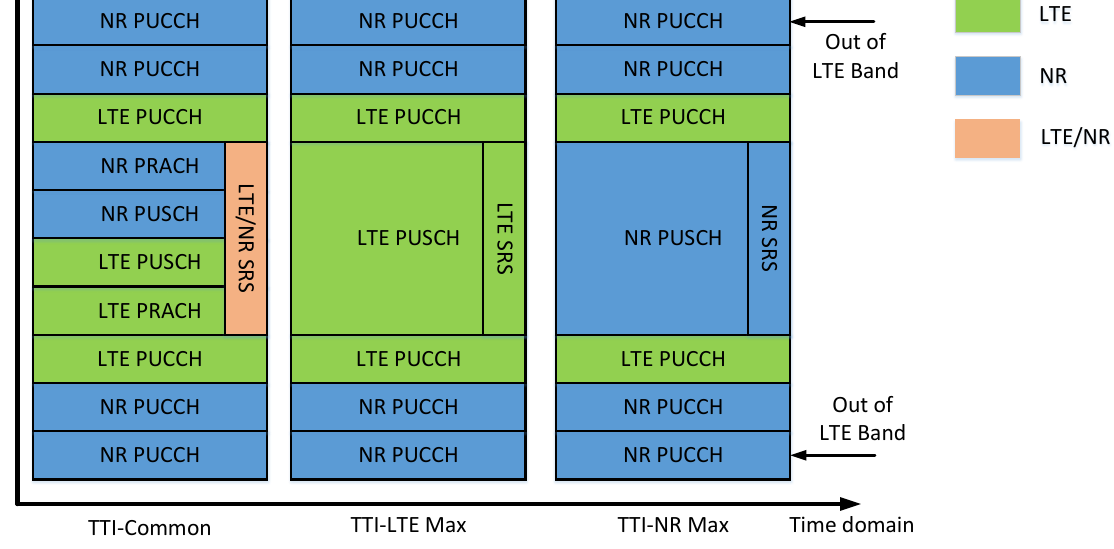
Figure 3. Uplink channel